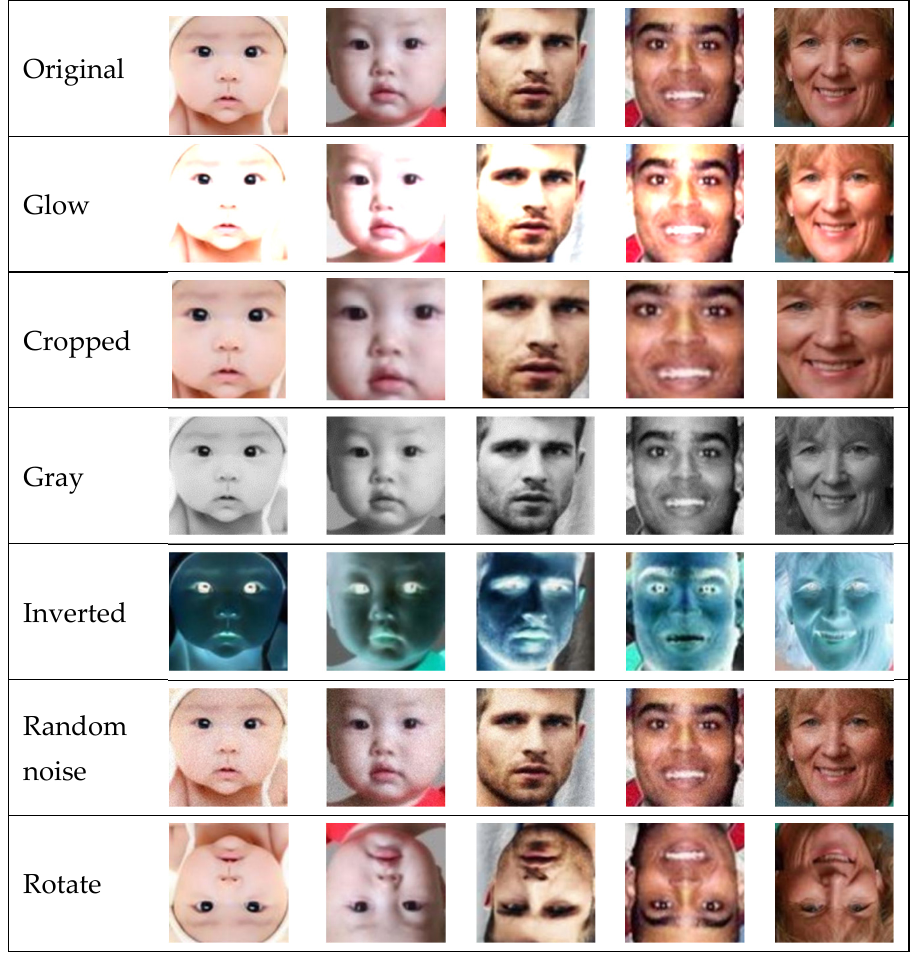
Figure 8. Filtered images sample [24].